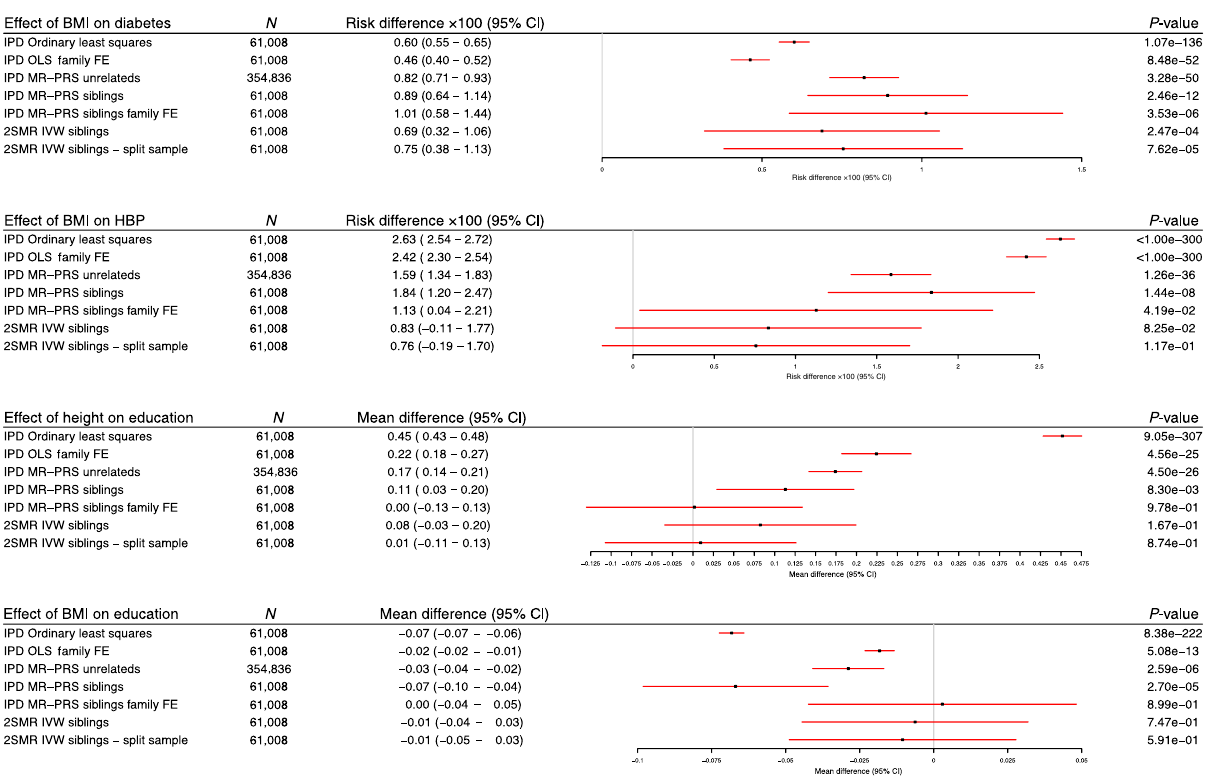
Fig. 3 Estimates of the effect of BMI on self-reported diabetes and high blood pressure and height and BMI on educational attainment using ordinary least squares, Mendelian randomization in unrelated individuals and samples of siblings, point estimates and 95% con fi dence intervals reported. All methods were consistent with higher BMI increasing diabetes and high blood pressure risk. Being taller and having lower BMI were observationally associated with higher educational attainment. The effects of height and BMI on educational attainment were attenuated but still apparent when using Mendelian randomization estimates based on unrelated individuals from HUNT and UK Biobank. The effects were eliminated after allowing for a family effect using individual-level or summary data Mendelian